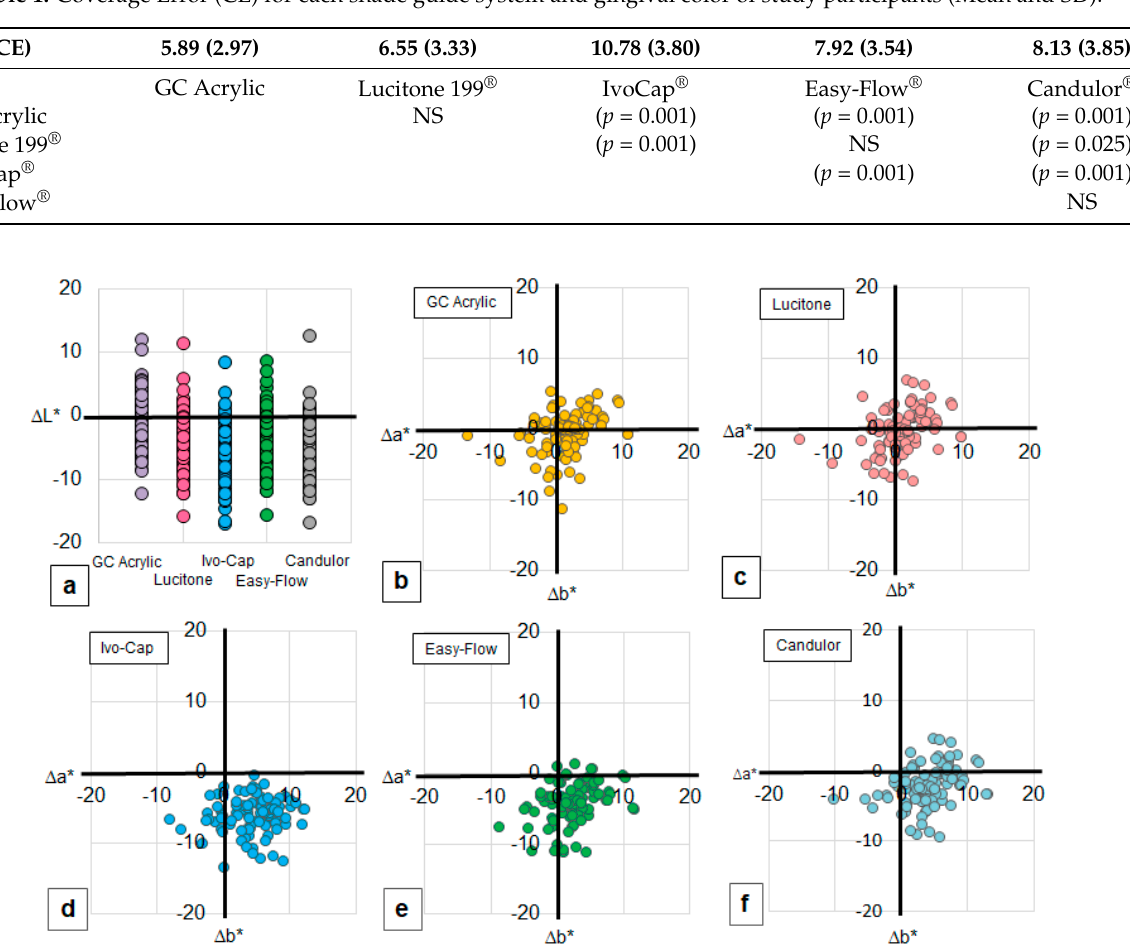
Figure 3. Direction and extent of CIELAB color coordinates with zero representing the patient (cid:48) s shade. ( a ) ∆ L* distribution, ( b ) ∆ a* − ∆ b* distribution of GC acrylic, ( c ) Lucitone, ( d ) Ivo-Cap, ( e ) Easy-Flow, ( f )